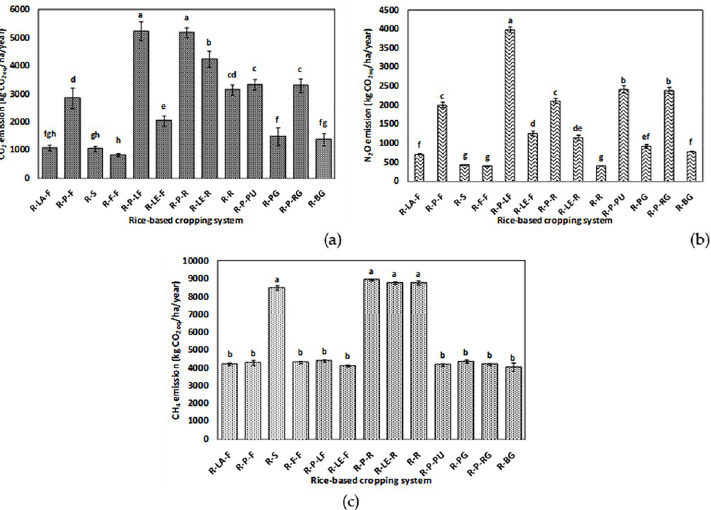
Fig 6. CO 2 , N 2 O and CH 4 emission from different rice-based cropping systems of the study area. [here, R-LA-F: rice-lathyrus-fallow, R-P-F: rice-potato-fallow, R-S: rice-sunflower, R-F-F: rice-fallow-fallow, R-P-LF: rice-potato- ladies finger, R-LE-F: rice-lentil-fallow, R-P-R: rice-potato-rice, R-LE-R: rice-lentil-rice, R-R: rice-rice, R-P-PU: rice- potato-pumpkin, R-PG: rice-pointed gourd, R-P-RG: rice-potato-ridge gourd, R-BG: rice-bitter gourd]. https://doi.org/10.1371/journal.pone.0233303.g006 rice, and rice-rice systems. Rice-vegetable systems recorded lower system GWP. The rice-bitter gourd and the rice-pointed gourd systems recorded lowest GWP, which was at par with that of the rice-fallow-fallow and the rice-lathyrus-fallow systems. System wise percent share of differ- ent emission sources to the total GWP can be envisaged from Fig 9. Irrespective of the systems, the highest emission of GHGs was from fertilizer, followed by diesel and pesticide, respectively. Yield-scaled GHG emission was estimated to curb the trade-off between the yield and GWP from the systems. It was observed that the rice-fallow-fallow system was highest in their